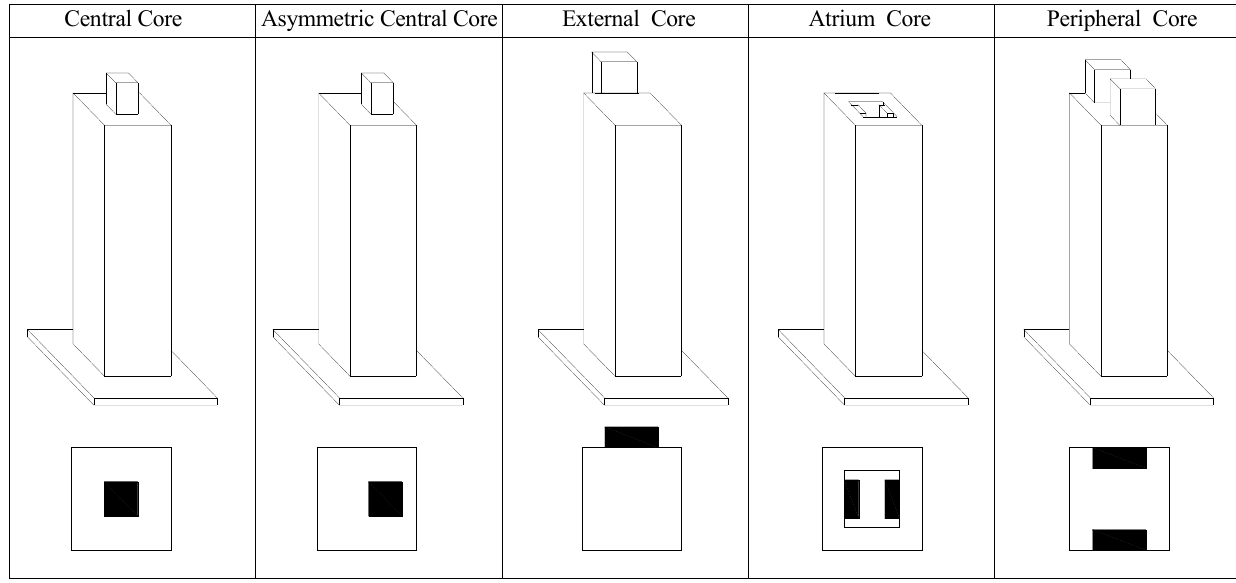
Figure 5. Core arrangement classification for tall buildings.